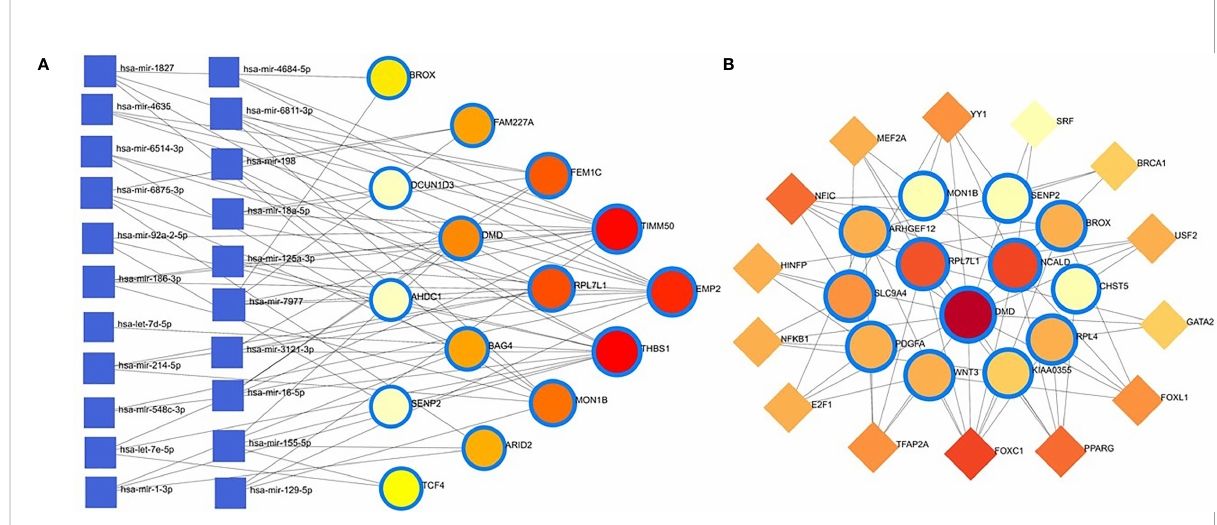
FIGURE 8 Genes ’ regulatory networks. (A) Gene regulatory networks (gene-miRNA) of the nasopharyngeal epithelial cell in COVID- 19 patients with the shared dysregulated genes. The square shapes and circular shapes represent the miRNA and genes, respectively. (B) Gene regulatory networks (transcription factors; TF) of the nasopharyngeal epithelial cell in COVID- 19 patients with the shared dysregulated genes. The square shapes and circular shapes represent the TF and genes,